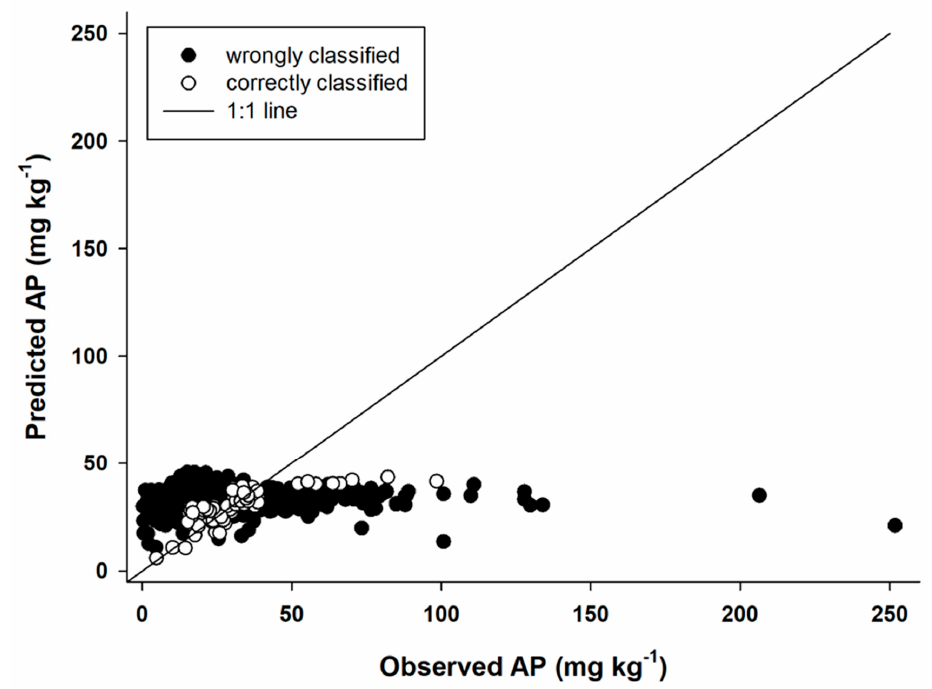
Figure 5. Scatterplot of the predicted AP values versus the observed AP values. Table 9. Allocation confusion matrix of